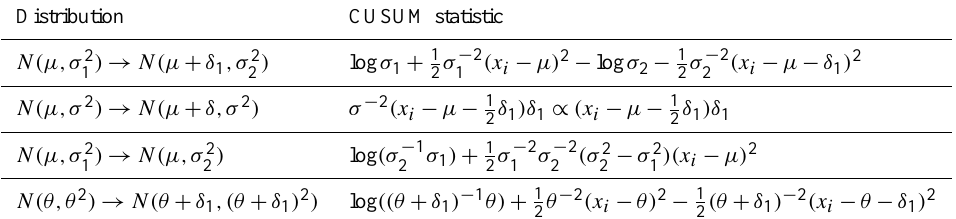
Table 2. CUSUM statistic for normal distribution: the first row is more general with both mean and variance change. The remaining three rows are special cases of the first